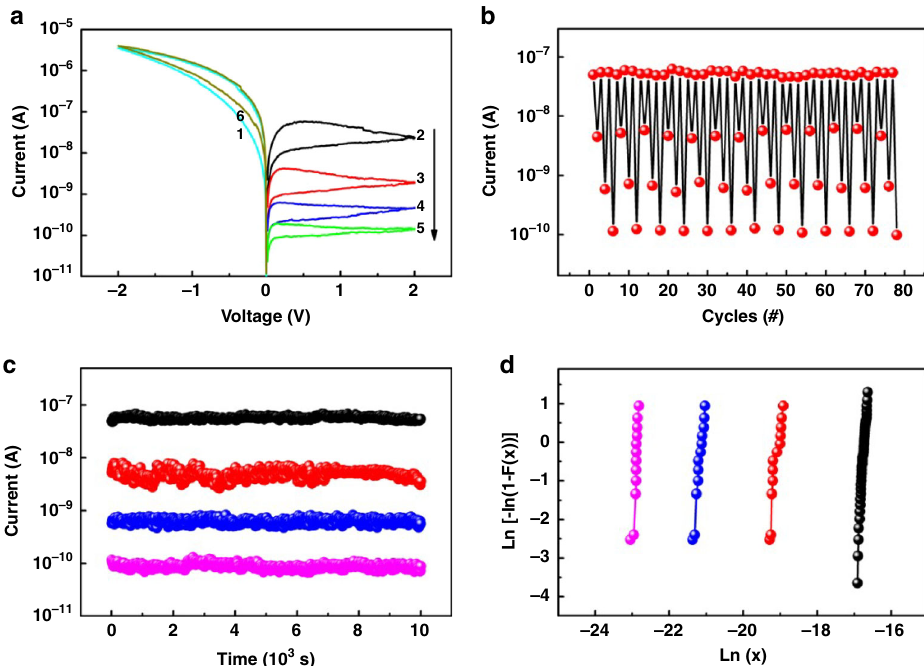
Fig. 4 Multilevel memristive switching characteristics in high resistance state. a Current – voltage curves of the ITO/PFTPA-Fc/Pt device. b Endurance and c retention performance of the multilevel storage. d Weibull distribution of the device current in the different conductance